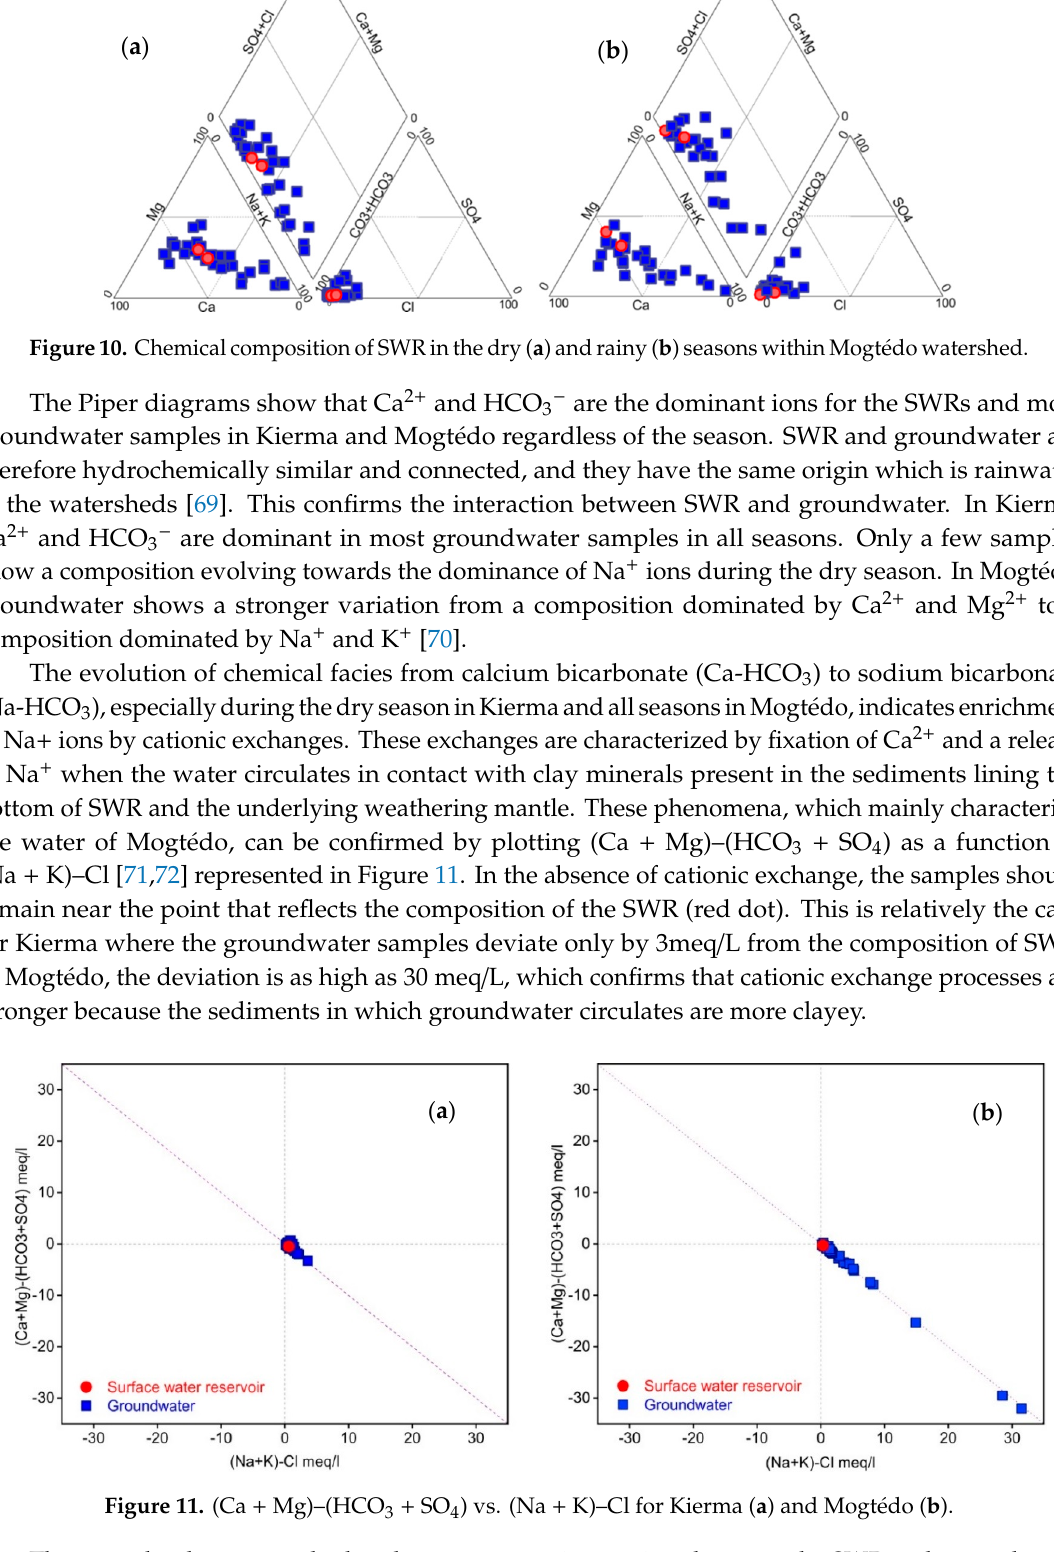
Figure 11. (Ca + Mg)–(HCO 3 + SO 4 ) vs. (Na + K)–Cl for Kierma ( a ) and Mogtédo ( b ).